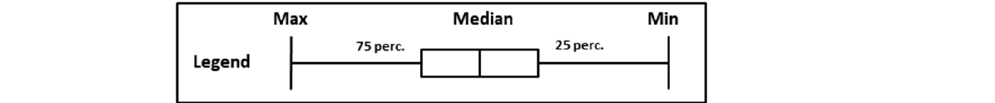
Figure 6. Box plots for the physical parameters of the natural springs of western Vermio Mt.